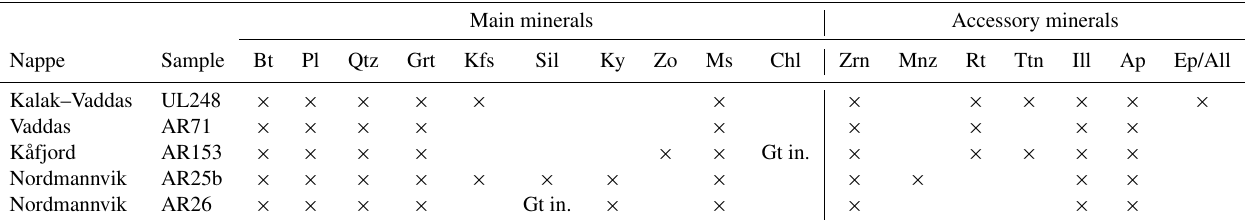
Table 2. Mineralogy for petrology